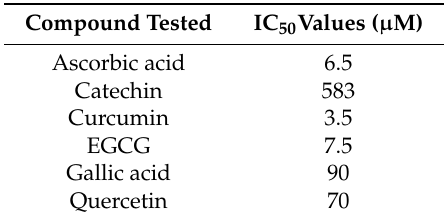
Table 1. IC 50 values of six dietary compounds in MCF-7 cells examined by MTT